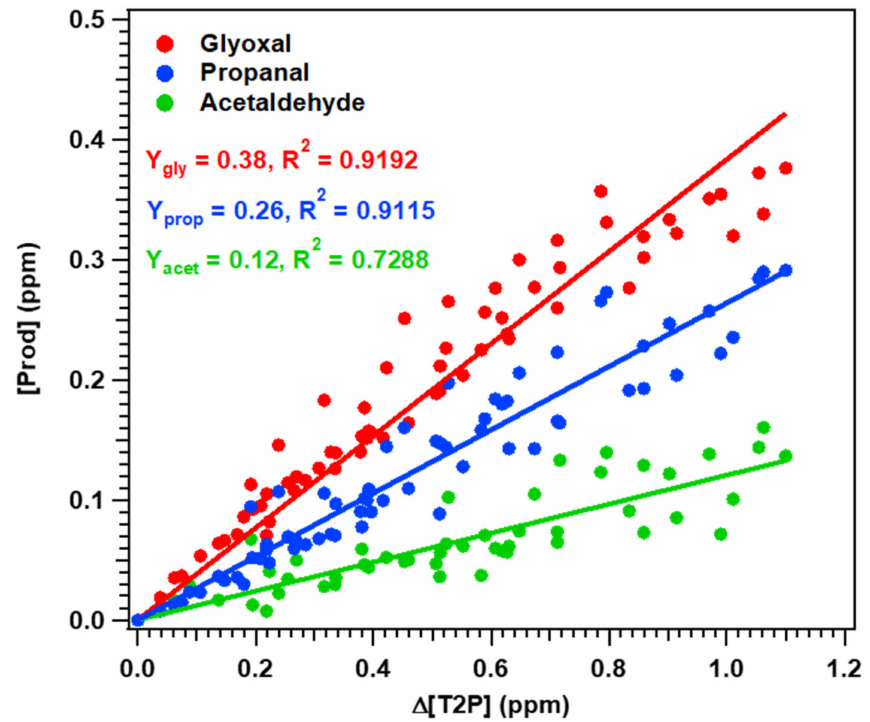
Figure 2. Product yield Yx plots obtained for the T2P ozonolysis without OH scavenger in QUAREC with x = glyoxal (red), propanal (blue) and acetaldehyde